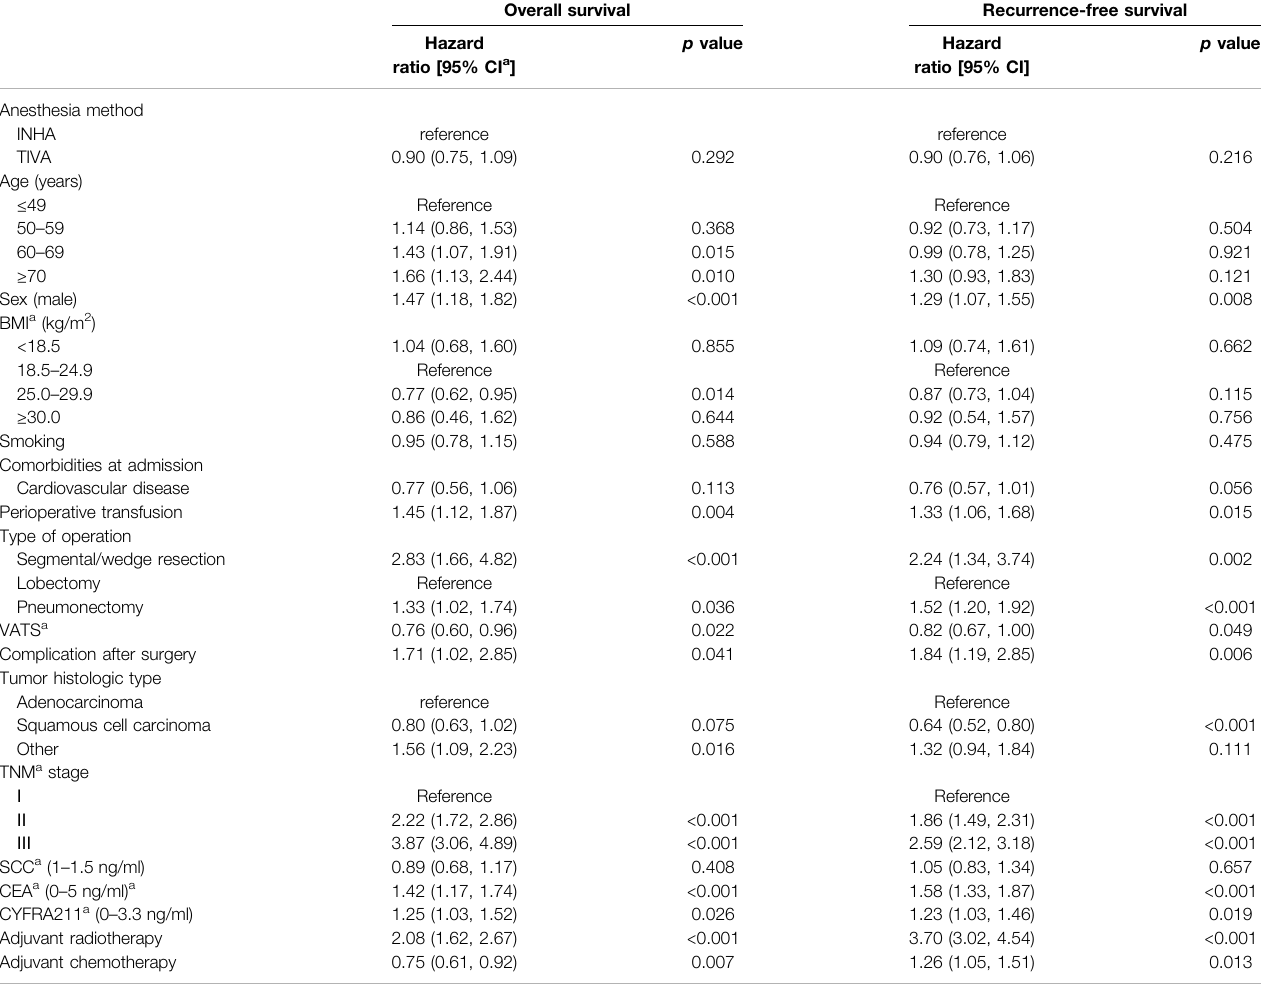
TABLE 3 | Multivariable Cox regression analysis for overall survival and recurrence-free survival in the total study